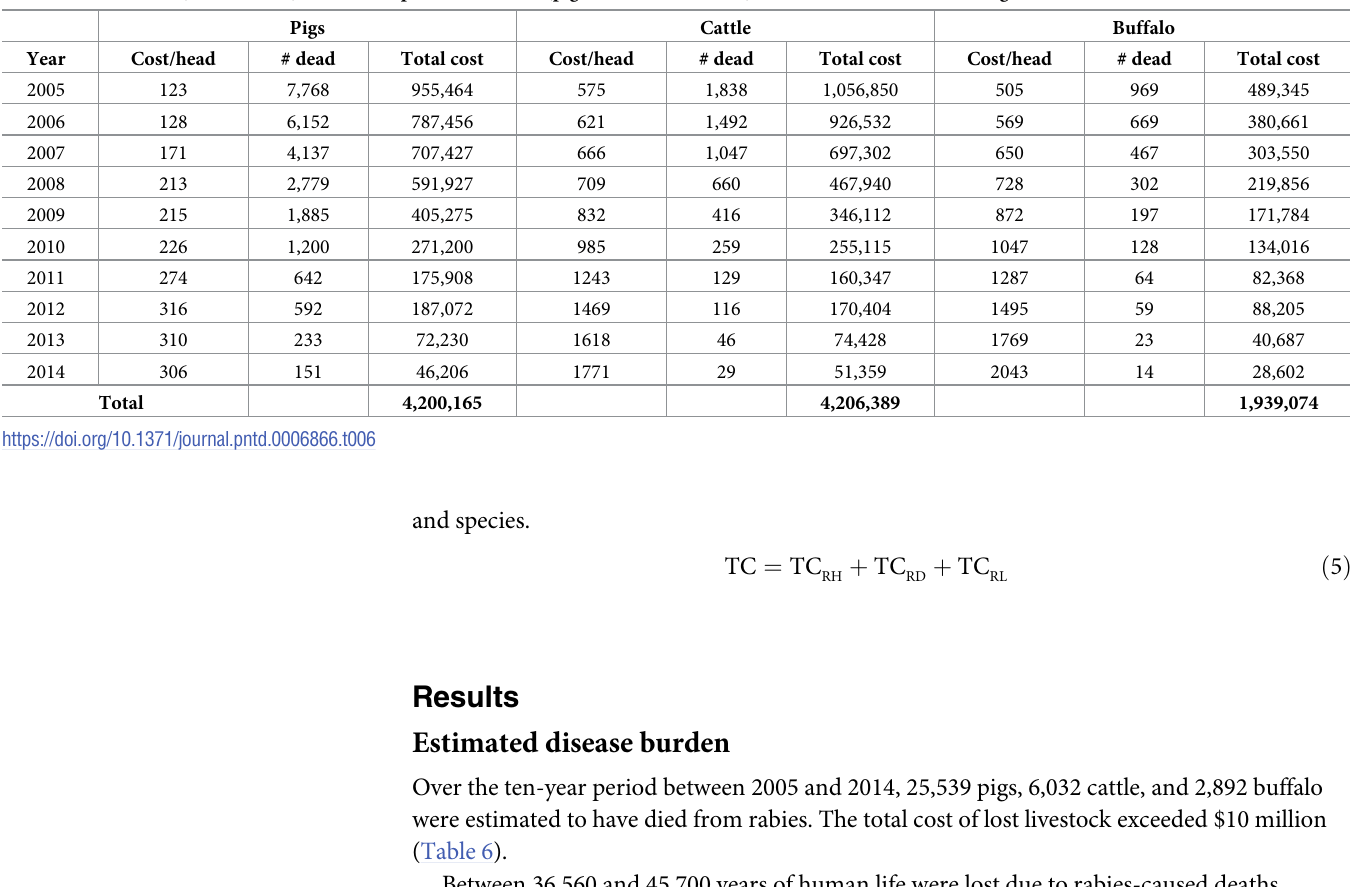
Table 6. Annual cost (in 2017 USD) of rabies impacts in livestock (pigs, cattle, and buffalo) in Viet Nam from 2005 through 2014.